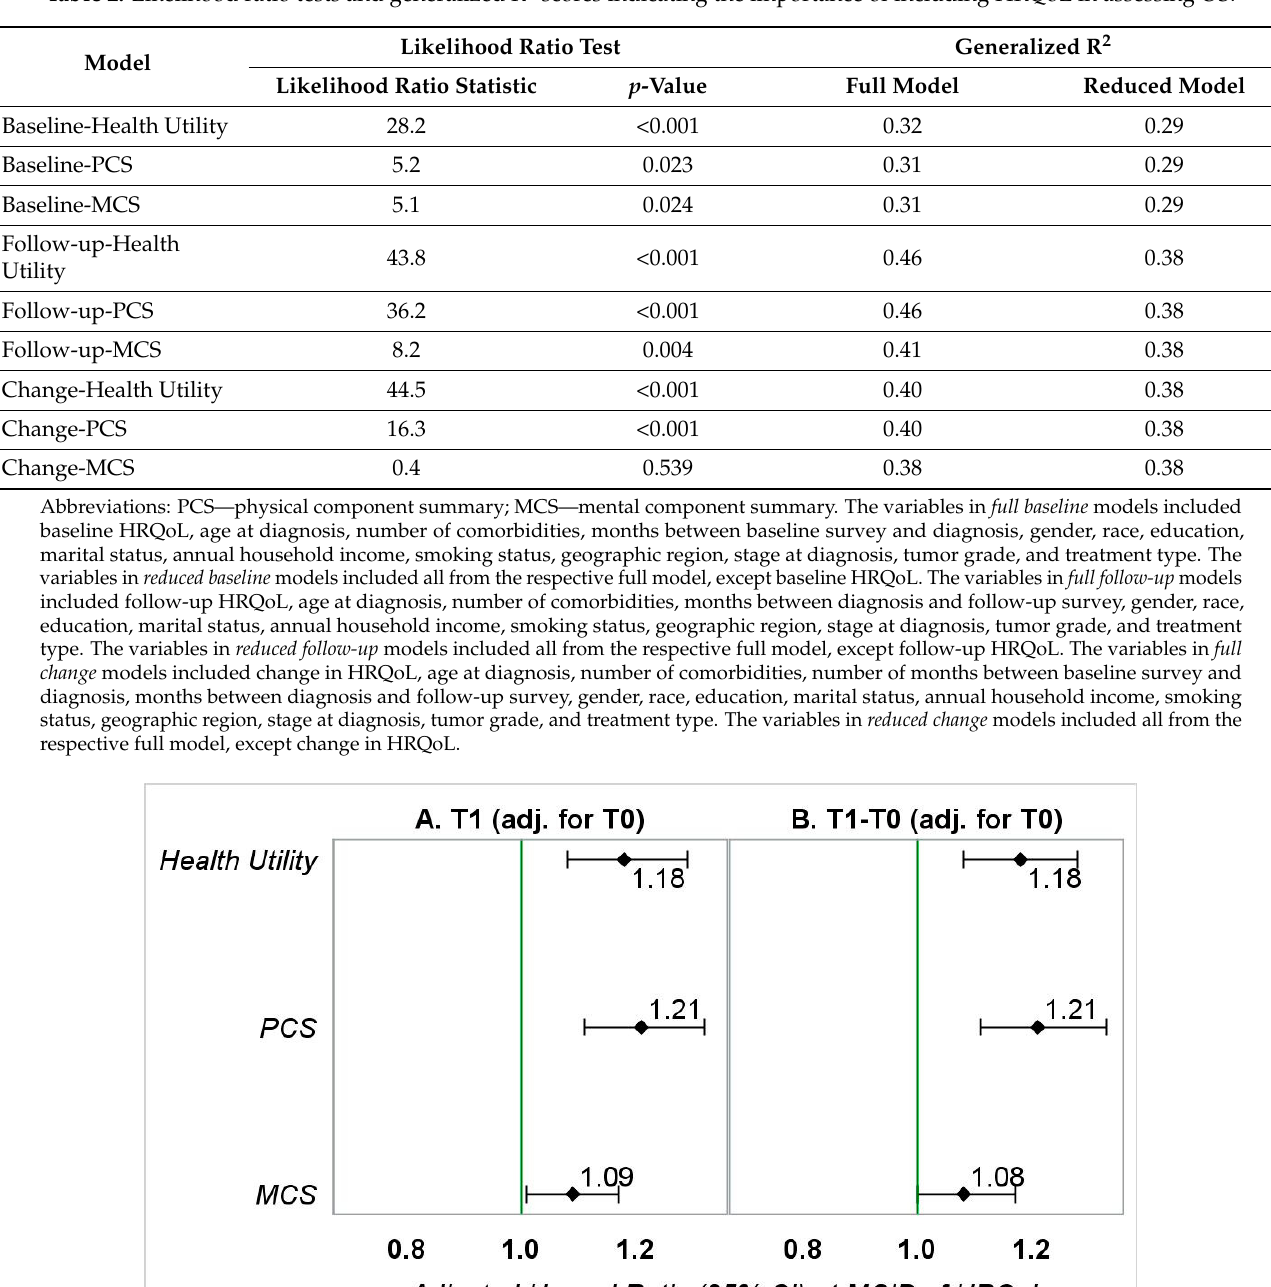
Table 2. Likelihood ratio tests and generalized R 2 scores indicating the importance of including HRQoL in assessing OS.